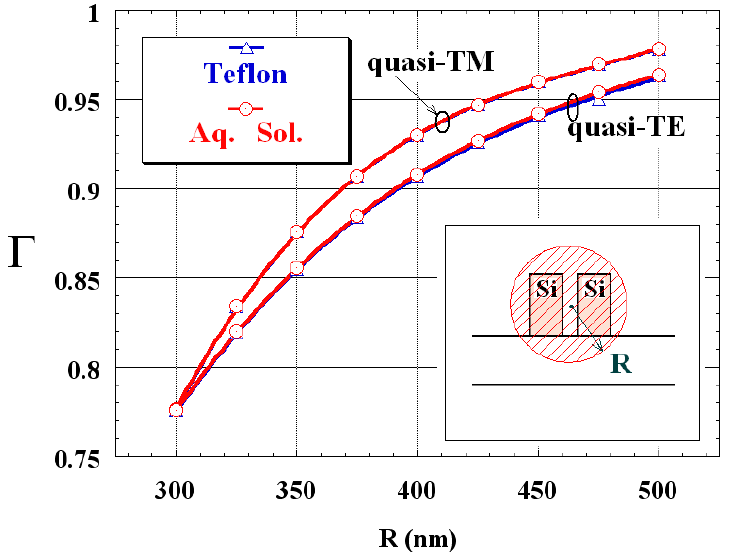
Figure 3 . Confinement factor in a circular region versus R (cover medium: Teflon or aqueous